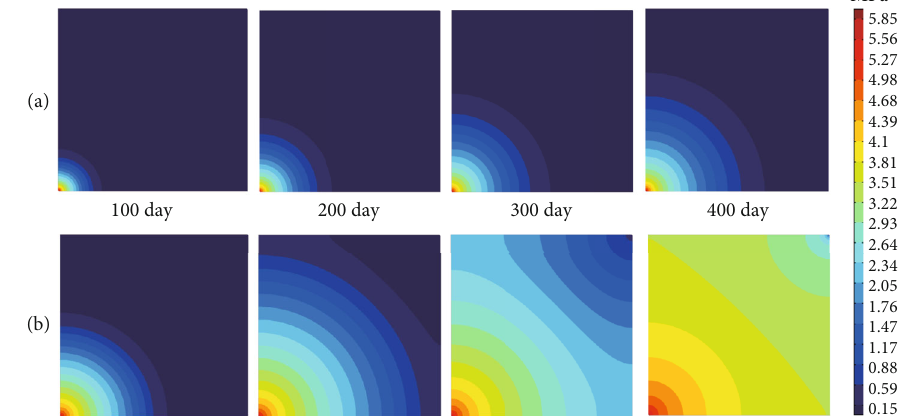
Figure 7: Distribution of injection pressure. (a) CO